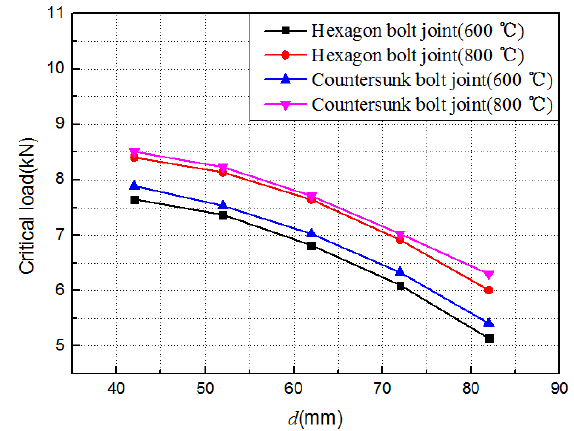
Figure 21. Evolution of the critical load with the distance d.